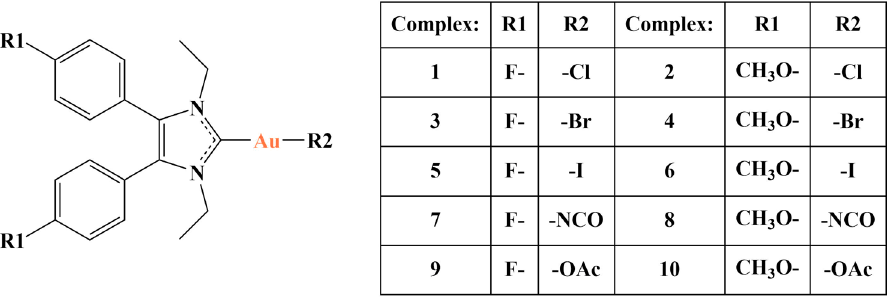
Figure 27. The complexes presented in [105]. IC 50 values (74.26 to 102.17 μ M) were about 2–3 times higher than the those for cisplatin. The authors concluded that thione ligands do not contribute to the antiproliferative activity of such gold(I) complexes. Alkynyl-gold complexes have been intensively studied in recent years for their antiproliferative effect [98]. They tend to exhibit significant anticancer effects, associated with TrxR inhibitory activity [106–109]. A number of investigations to that effect have been carried out recently. A phenanthrene bridge was substituted with two terminal alkynyl groups in order to build potential anticancer complexes with two gold(I)-phosphine centers [110] (Figure 28). The potential antiproliferative activity of both gold complexes was assessed against the MCF-7, HEPG-2, PC-3 and MOLT-4 cancer cell lines (SRB, 72 h). The phenanthrene- ethynyl “bridging” ligand had very low activity against all tested strains. Both gold complexes behaved in a similar manner to the positive control cisplatin (IC 50 varied at 18– 28 μ M with all cancer cell lines). DNA binding was noted for both complexes and the ligand. The authors of the study proposed that substituting the phenanthrene skeleton at positions 9 and 10 would allow for modification of lipophilicity of the complexes improving their solubility—a common issue with alkynyl-gold compounds [111].